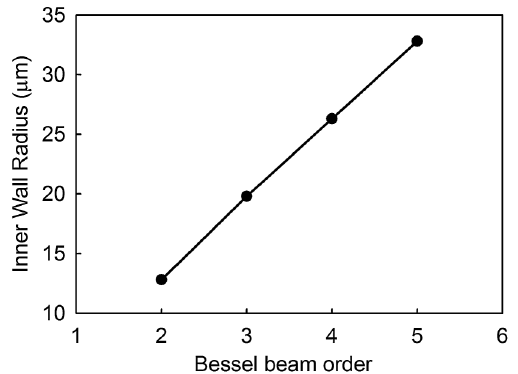
FIG. 7. Dependence of inner wall radius with Bessel-beam order.